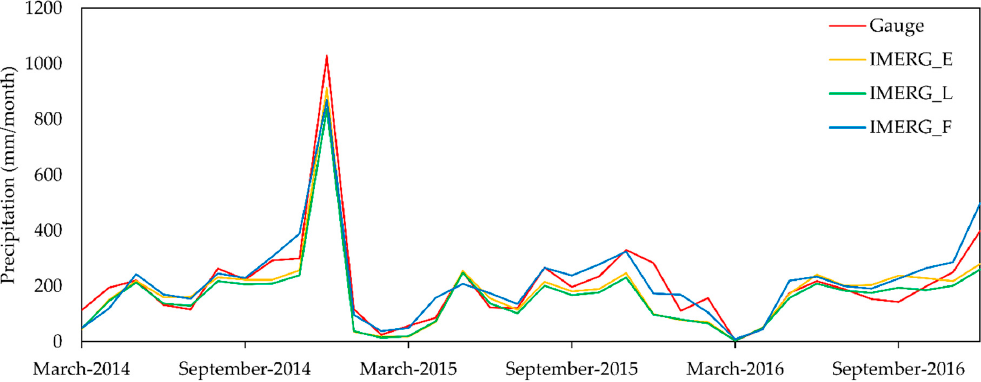
Figure 2. Temporal pattern of monthly precipitation estimated by gauge and the Global Precipitation Measurement Integrated Multi-Satellite Retrievals (GPM IMERG) products from March 2014 to December 2016 . Table 1. Statistical analysis of the IMERG